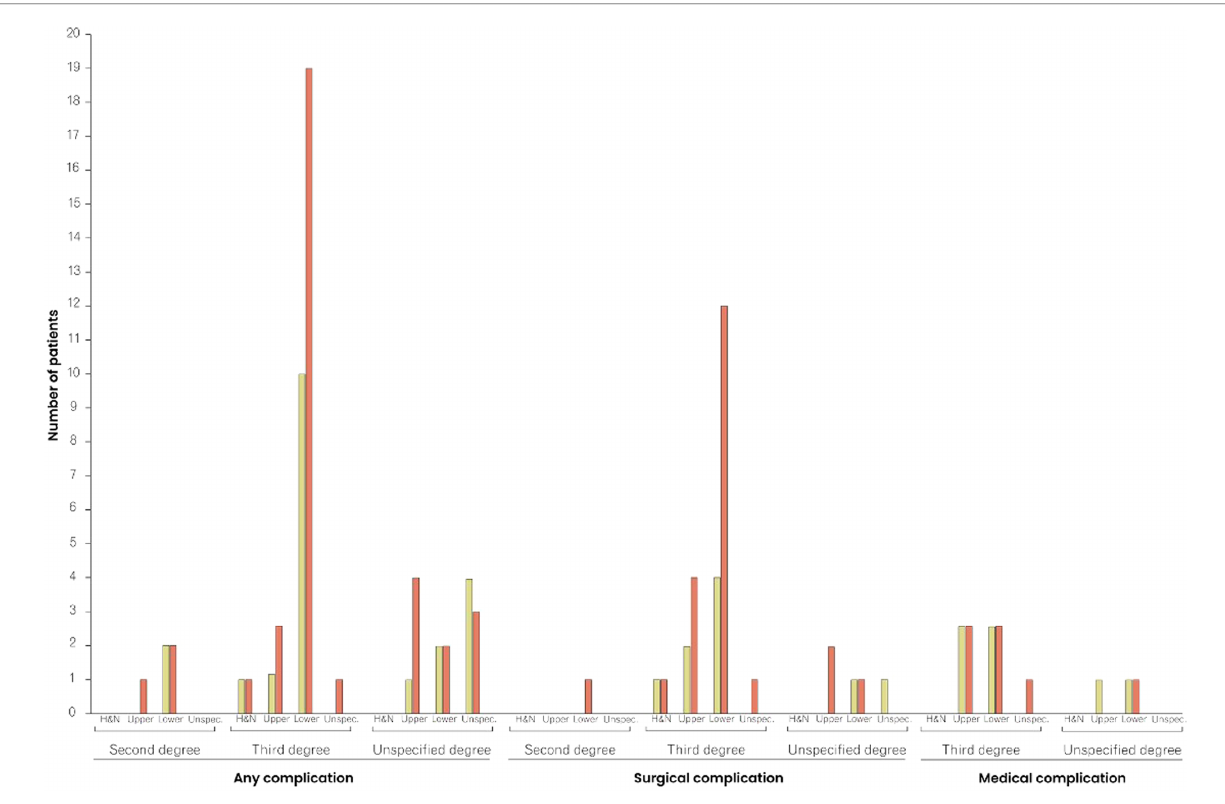
FIGURE 2 Comparison of complication rates between patients <60 and ≥ 60 years of age, strati fi ed by type of complication, burn degree, and affected area. The red columns represent the frequency of complications in patients ≥ 60 years of age, and the yellow columns in patients <60 years of age. H&N, Head and